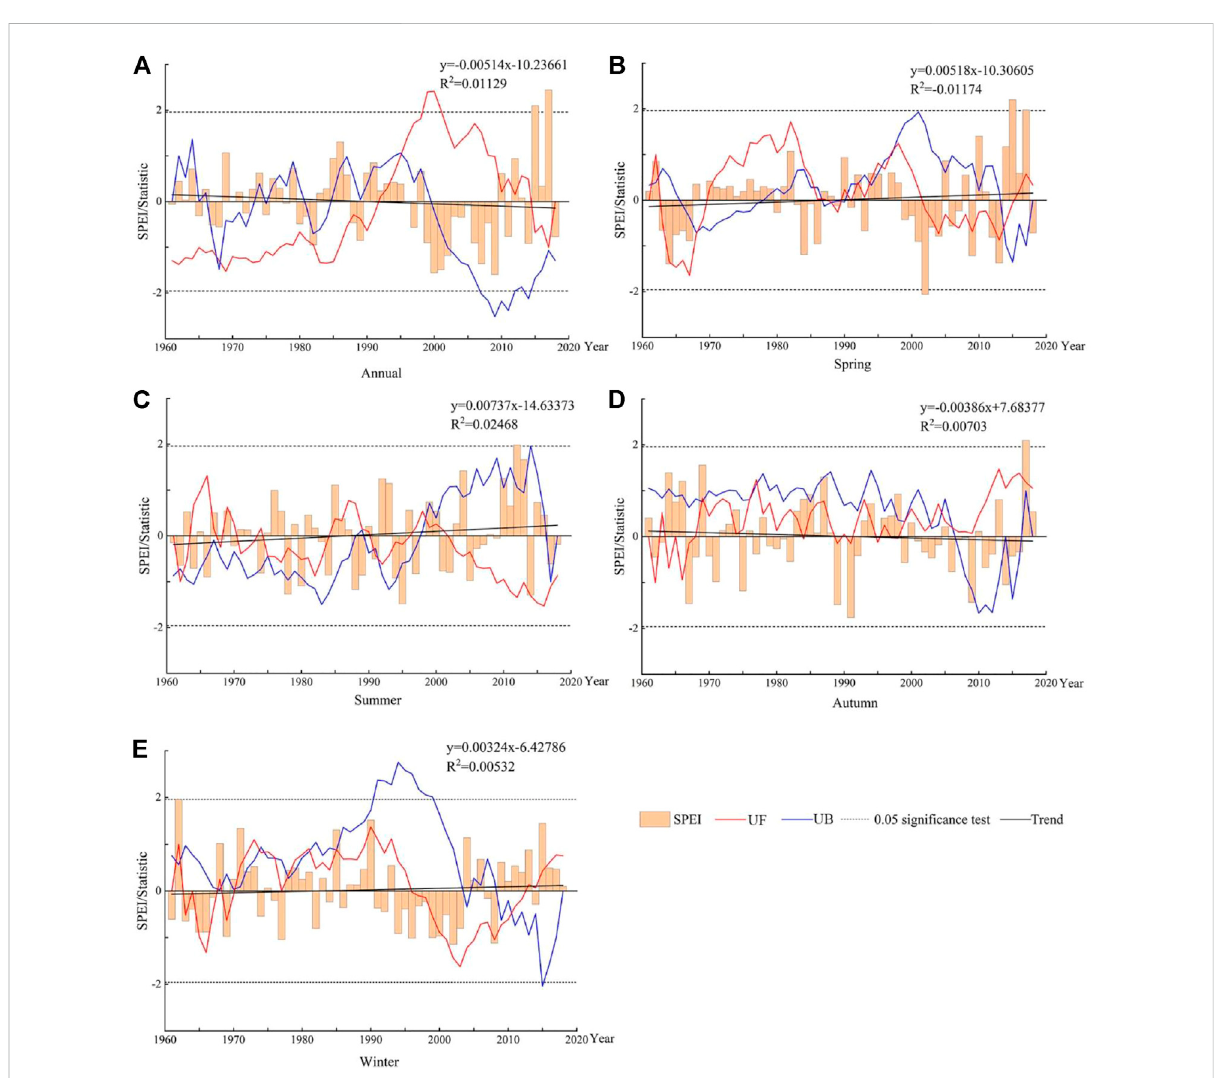
FIGURE 3 SPEI changes and M-K mutation test in the LRB from 1961 to 2018. (A) is the annual change trend and M-K mutation test of SPEI. (B – E) are the spring, summer, autumn and winter changes and M-K mutation test of SPEI,